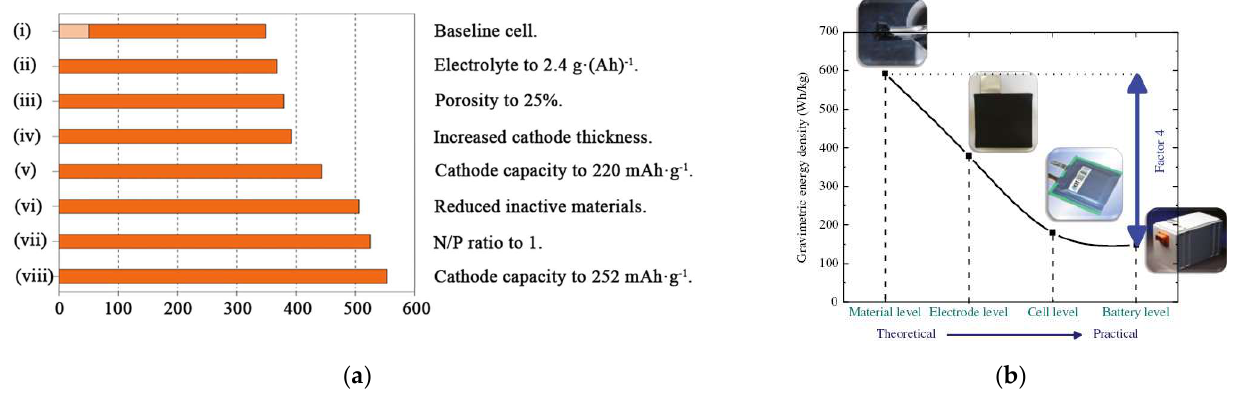
Figure 1. ( a ) Calculated cell−level specific energy based on different strategies [11]. ( b ) The specific energy density based on a standard 52Ah pouch cell and state−of−the−art packs [10].